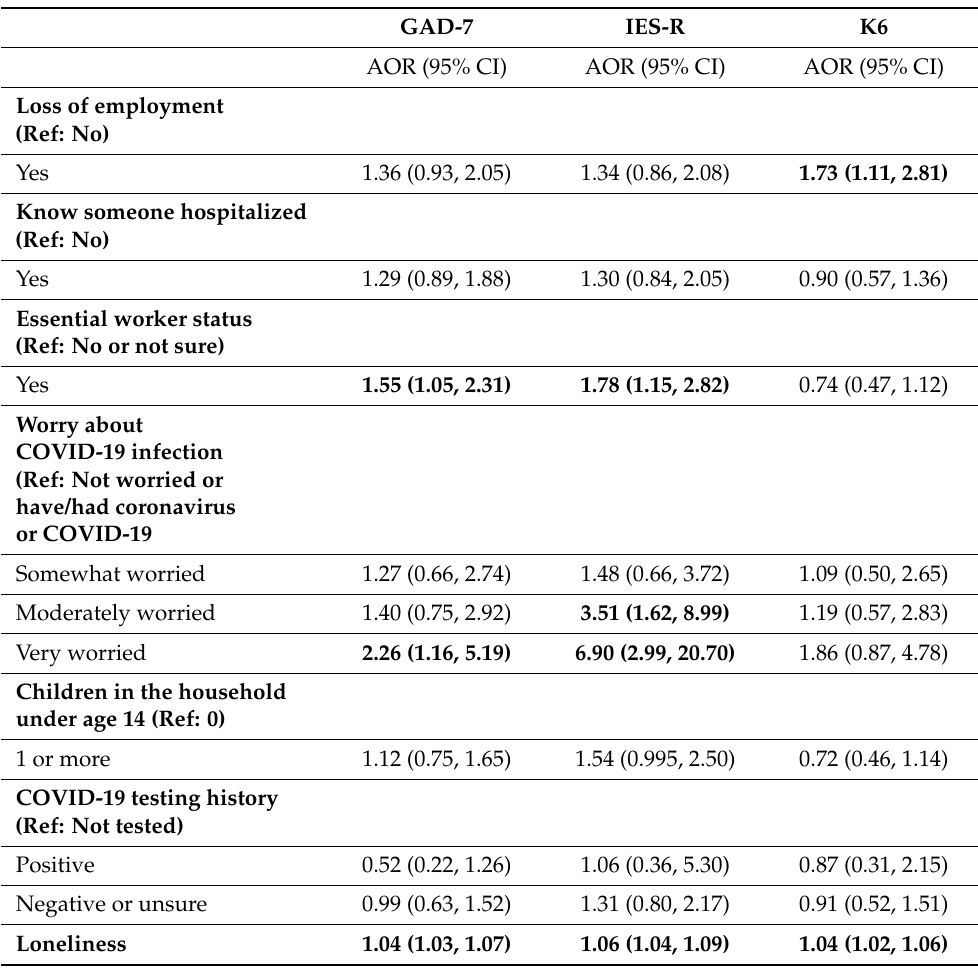
Table 5. Fully adjusted logistic regression models testing associations of sociodemographic character- istics and COVID-19-related stressors with mental health symptoms. GAD-7 IES-R K6 AOR (95% CI) AOR (95%